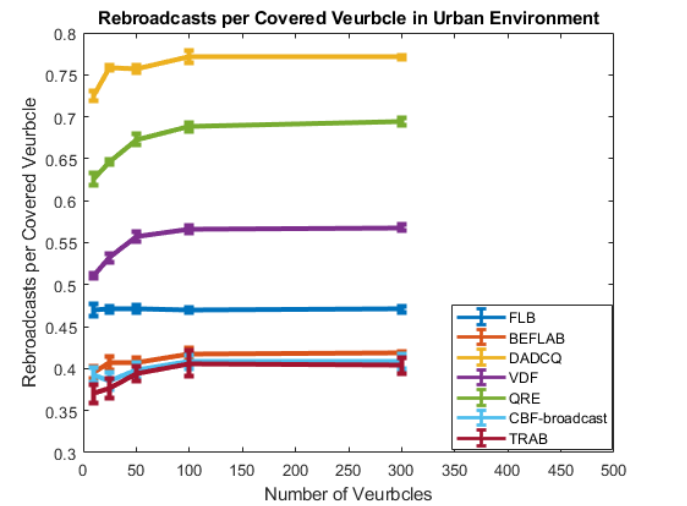
Figure 15. Urban rebroadcasts per covered